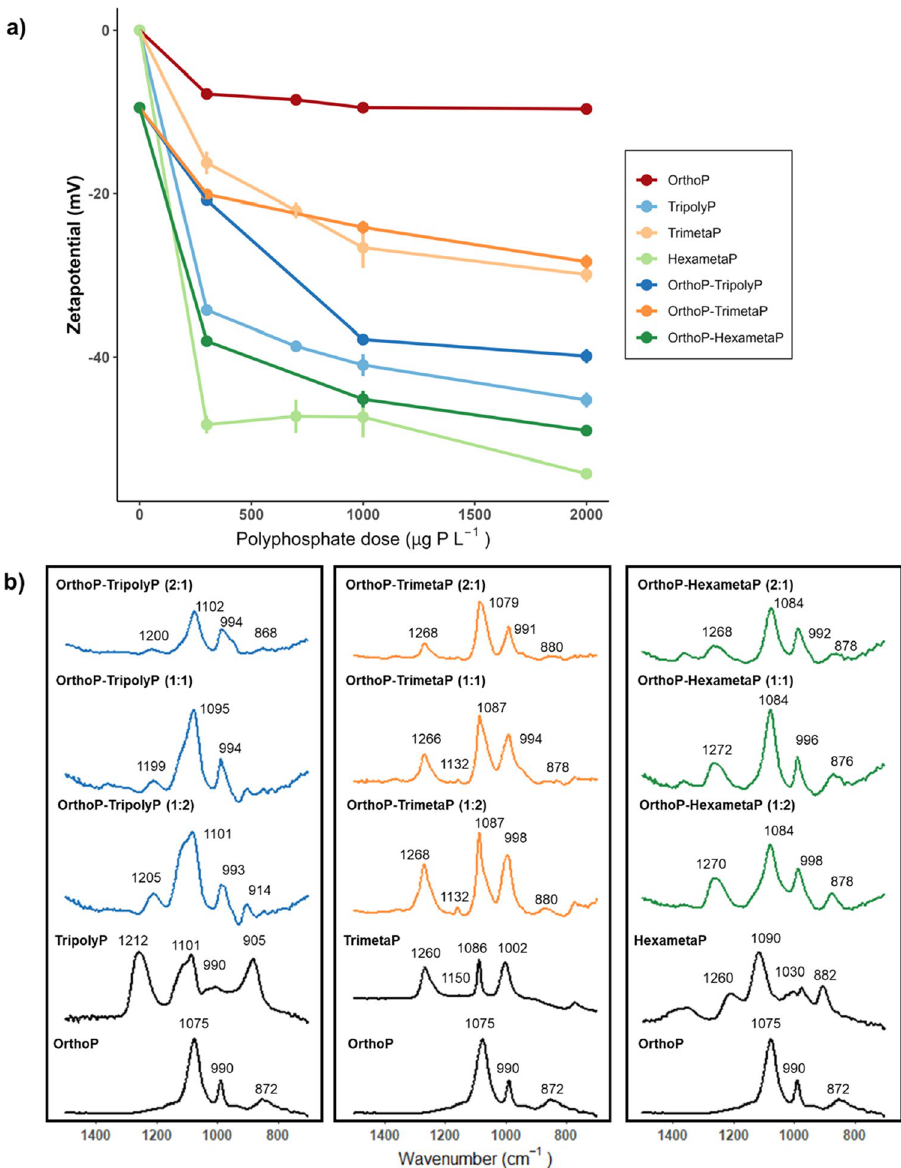
Figure 7. ( a ) Zetapotential and ( b ) ATR-FTIR spectra of adsorbed orthophosphate, polyphosphates, and orthophosphate–polyphosphates at pH 7.0. Orthophosphate:polyphosphate ratios are presented in brackets. Reference ATR-FTIR spectra of free orthophosphate and polyphosphate solutions are presented as solid black lines. All ATR-FTIR spectra were recorded in a DIC 5 mg C L −1 electrolyte